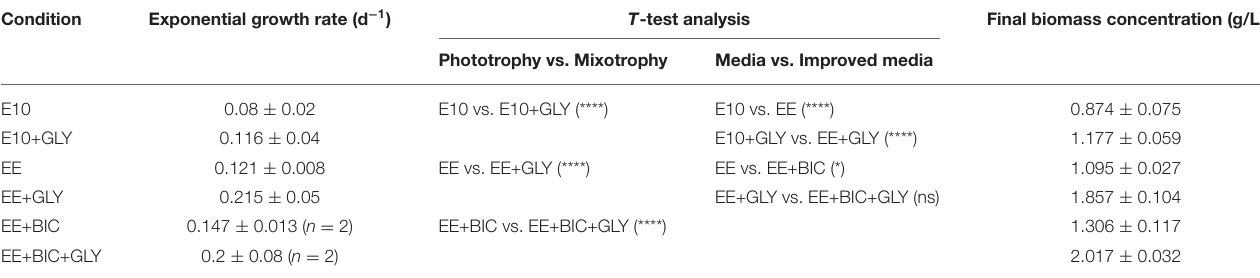
TABLE 3 | Exponential growth rate, t -test analysis, and final biomass concentration in the different media. Condition